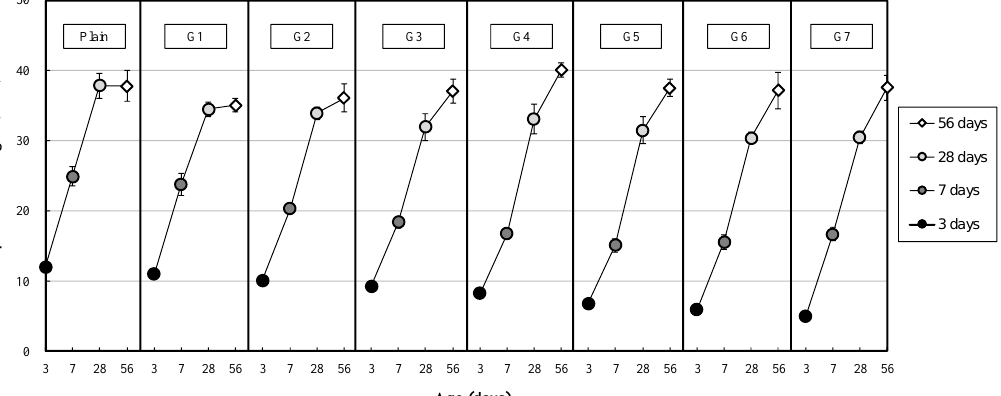
Figure 7. Result of compressive strength with respect to age.